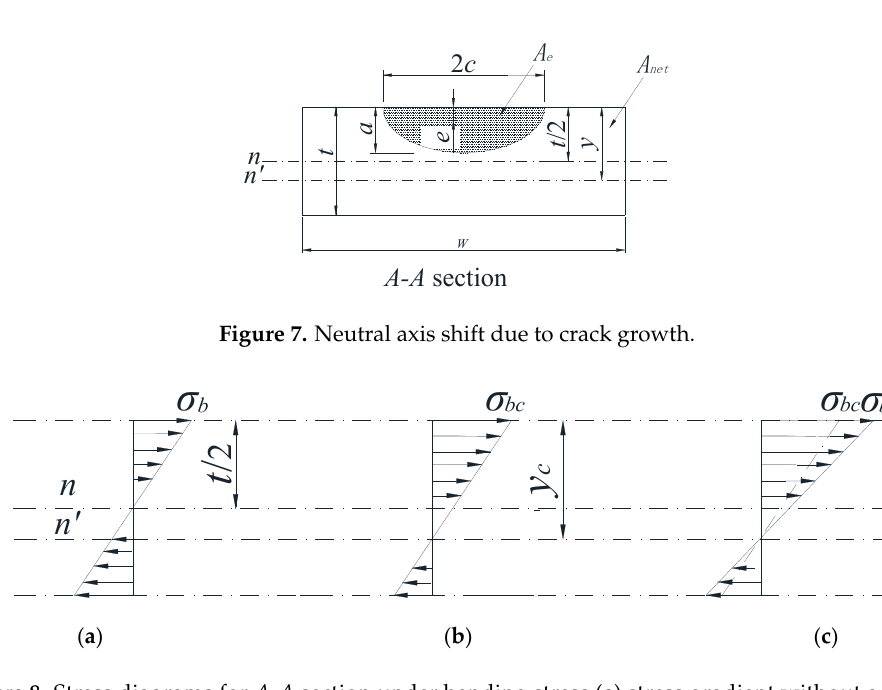
Figure 8. Stress diagrams for A - A section under bending stress ( a ) stress gradient without a neutral axis shift; ( b ) stress gradient with a neutral axis shift; ( c ) actual stress gradient with a neutral axis shift.